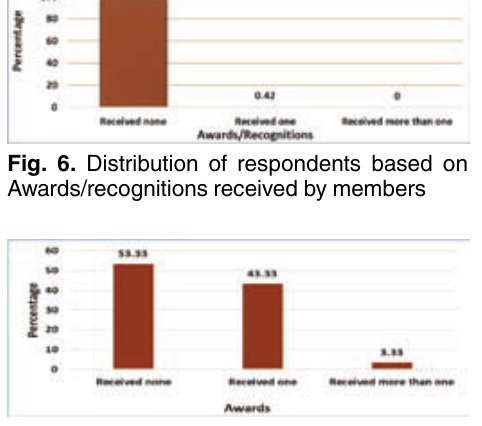
Fig. 7. Distribution of BMCs based on